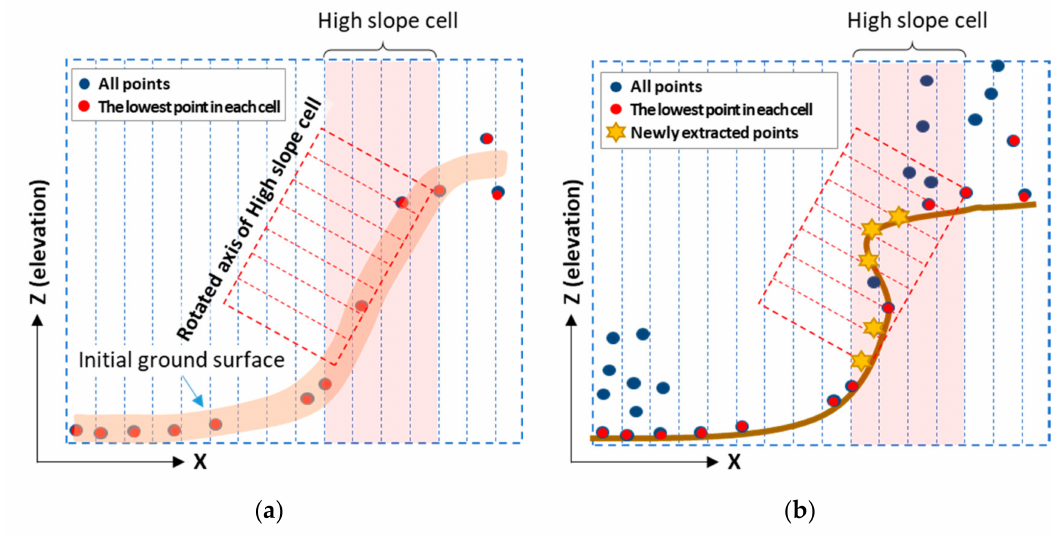
Figure 6. Extracting ground points after axis rotation in high slope cells: ( a ) rotating axis of high slope cell; ( b ) newly extracted